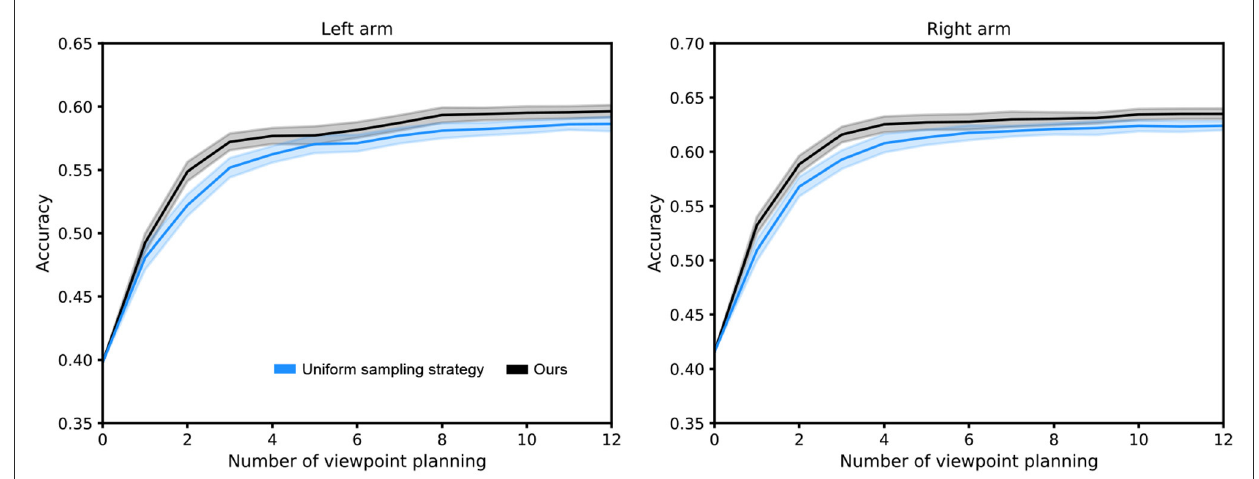
FIGURE9 Performance comparison between our sampling strategy and uniform sampling strategy. The capacity of the viewpoint transition buffer is 10 6 . The shaded region represents the standard deviation of the average evaluation over 10